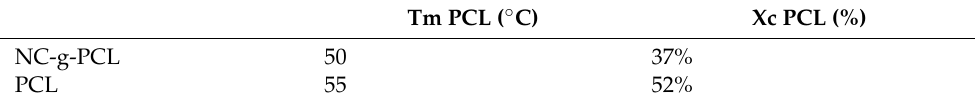
52% and 37%, respectively (Table 1). The PLLA chains were amorphous. Table 1. Melting temperature (Tm) and degree of crystallinity (Xc) data obtained by DSC.